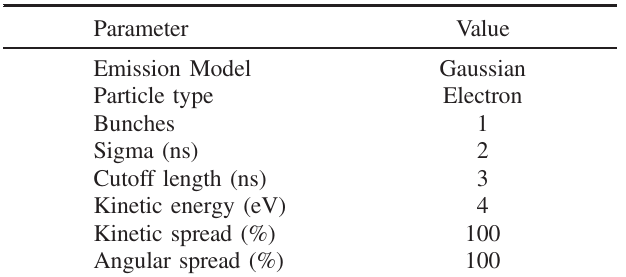
TABLE VI. Electron beam parameters for the primary electron emission.